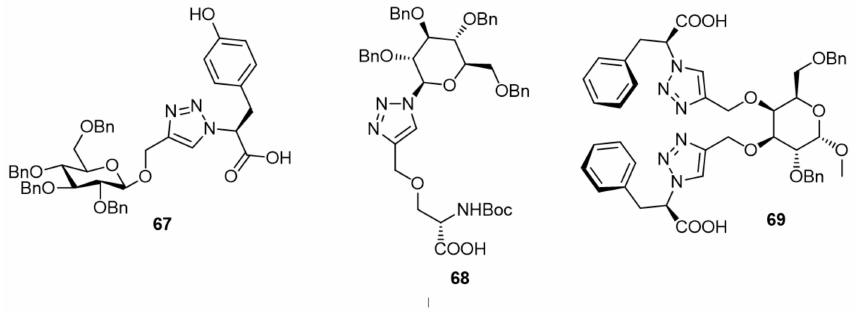
Figure 8. Cdc25 inhibitors based on